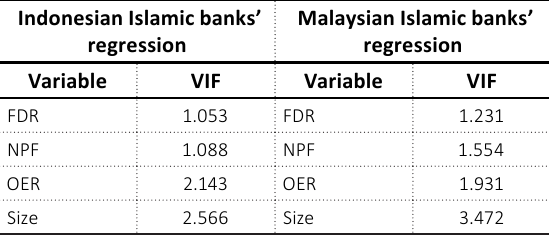
Table 8. Multicollinearity test results